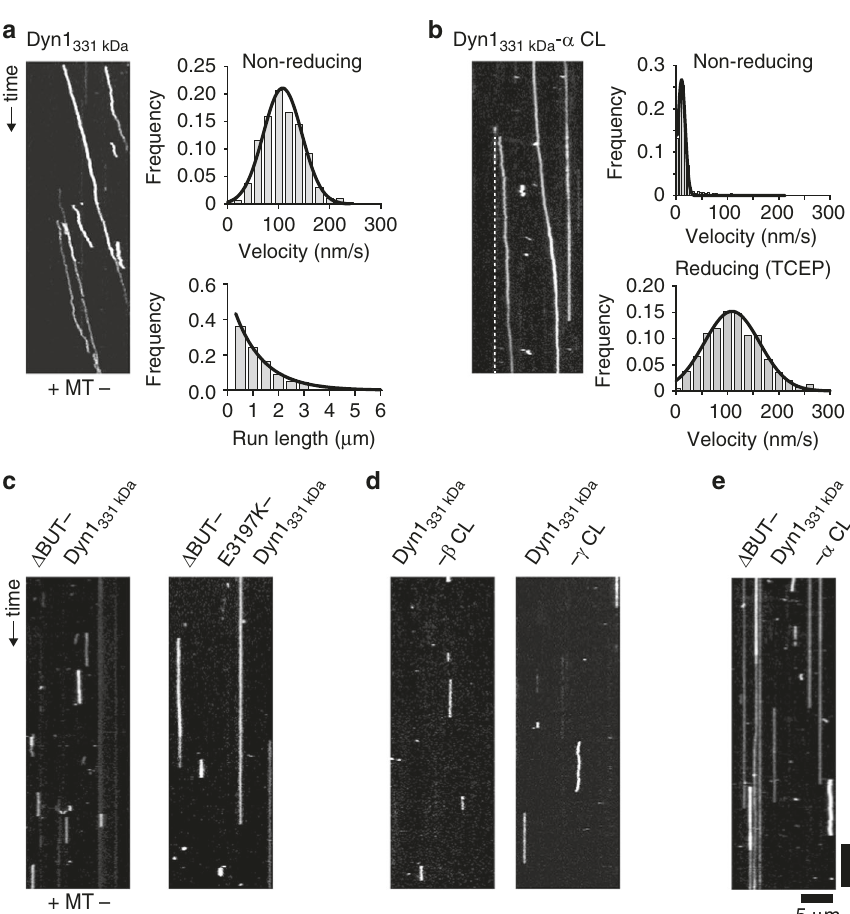
Fig. 7 Stalk-buttress interactions are essential for dynein motion. a Antibody-based dimerization of WT Dyn1 331kDa results in processive runs under non- reducing conditions in the single-molecule TIRF assay at 1 mM ATP (left). Diagonal lines in the kymograph represent dimerized dynein molecules that are moving over time. Fitting the histogram of measured velocities with a Gaussian (black line, top right), results in a mean velocity of 108 ± 2 nm/s (±SEM; N = 255). A histogram of measured run lengths fi t with an exponential function (black line, bottom right) yields a characteristic run length of 1.1±0.1 μ m (±SEM; N = 255) (source data are provided as a Source Data fi le). b In contrast to the motors with the cross-linked β and γ stalk registrations ( d ), Dyn1 shows highly processive motion (left) (the dashed white line serves as a visual guide to help recognize the slow moving Dyn1 331kDa - α CL mutant) under non- reducing conditions. Fitting the histogram of measured velocities with a Gaussian (black line, top right), yields a mean velocity of 10.6±0.4nm/s (±SEM; N = 336) (top right). Performing the experiments in the presence of 2mM TCEP increases the velocity to 109±3nm/s (±SEM; N = 281) (bottom right), demonstrating the reversibility of the cross-linking of the stalk helices (source data are provided as a Source Data fi le). c Kymograph analysis of the antibody- dimerized motors with the buttress truncations reveals that neither Δ BUT1-Dyn1 331kDa (left) nor Δ BUT-E3197K-Dyn1 331kDa (right) move along MTs. Instead, both motors show non-motile MT interactions (increasing the ionic interaction strength between MTs and the MTBD via the E3197K mutation increases the lifetime of the non-motile binding events, see Supplementary Fig. 9b). d Kymograph analysis of the antibody-dimerized WT Dyn1 331kDa - β CL and non-motile interactions, demonstrating the importance of stalk-buttress interactions. The depicted scale bars are the same for all kymographs shown